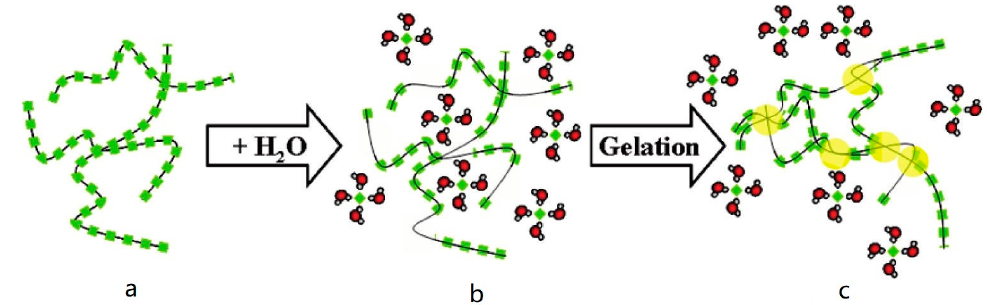
Figure 3. NMR-based illustration of the mechanism of water-induced gelation of cellulose dissolved in TBAF/DMSO. The symbols are: red dots = water molecules, green squares = F − (associated with cellulose in ( a ), solvated by water in ( b ), partially exposed cellulose chains, which leads to reaggregation ( c ), black lines = cellulose chains; yellow circles = hydrogen bond regions between cellulose chains; reprinted with permission from [82], Copyright (2009) American Chemical Society.